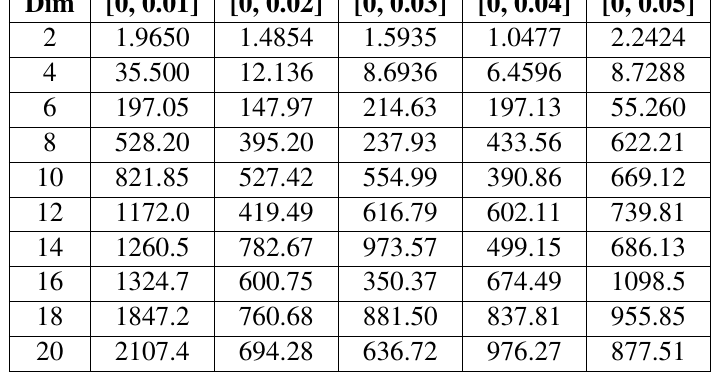
Table 5: Results on Rosenbrock function from 2 dimensions to 20 dimensions